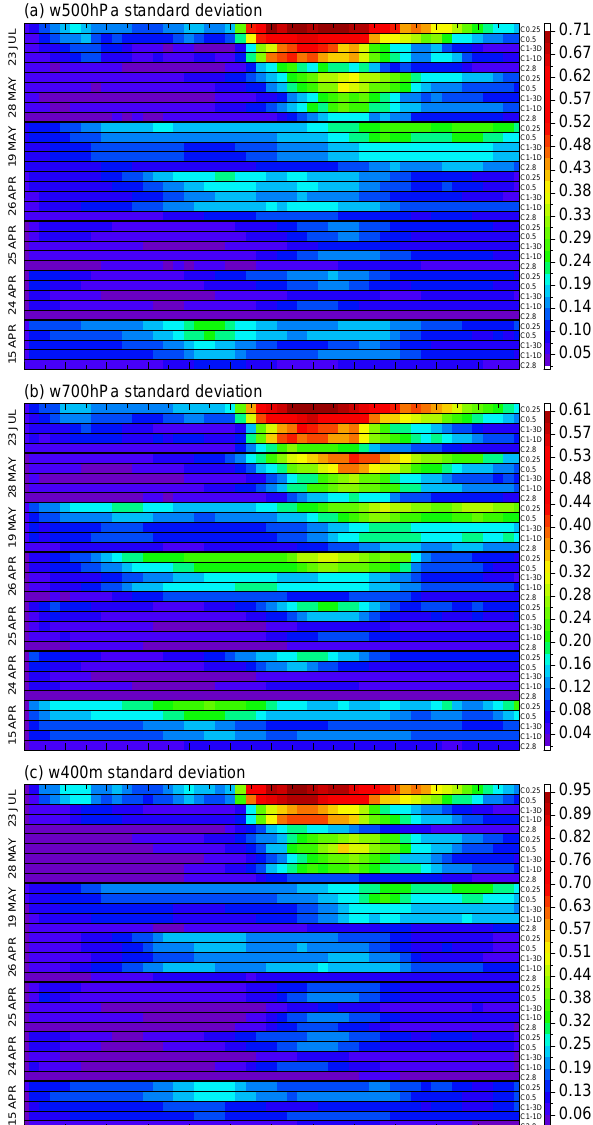
Figure 15. Standard deviation of the vertical velocity (in ms − 1 ) at 500hPa (a) , 700hPa (b) , and 400ma . g . l . (c) .